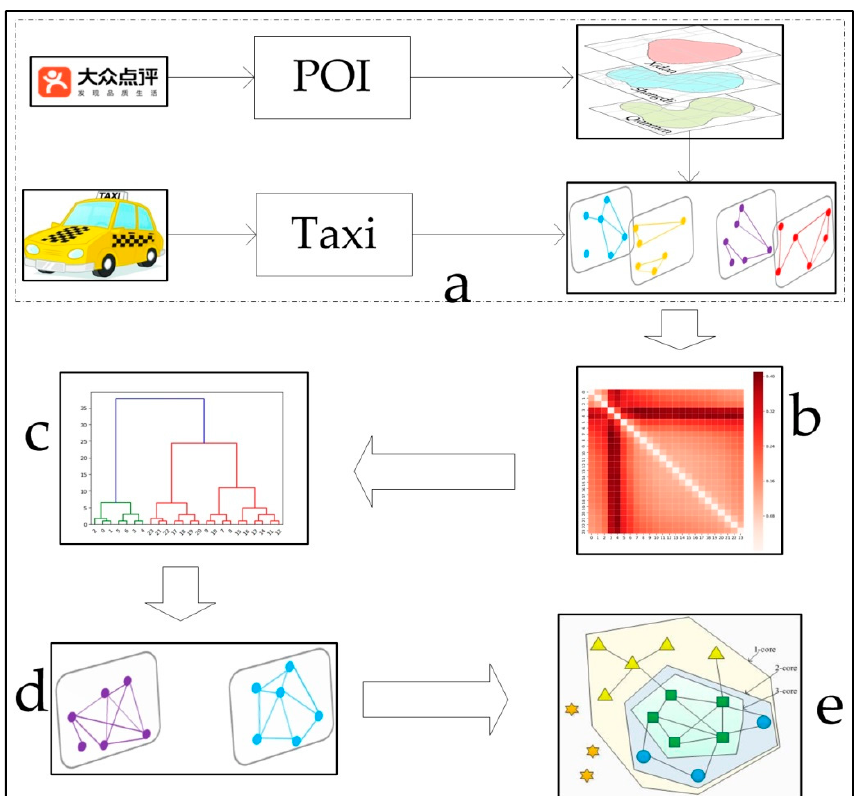
Figure 3. Overall research structure and data-preprocessing flowchart. ( a ) Extracting place footprints; ( b ) Jensen–Shannon distance between snapshots; ( c ) hierarchical-clustering method; ( d ) aggregating the layers; and ( e ) weighted K-core decomposition